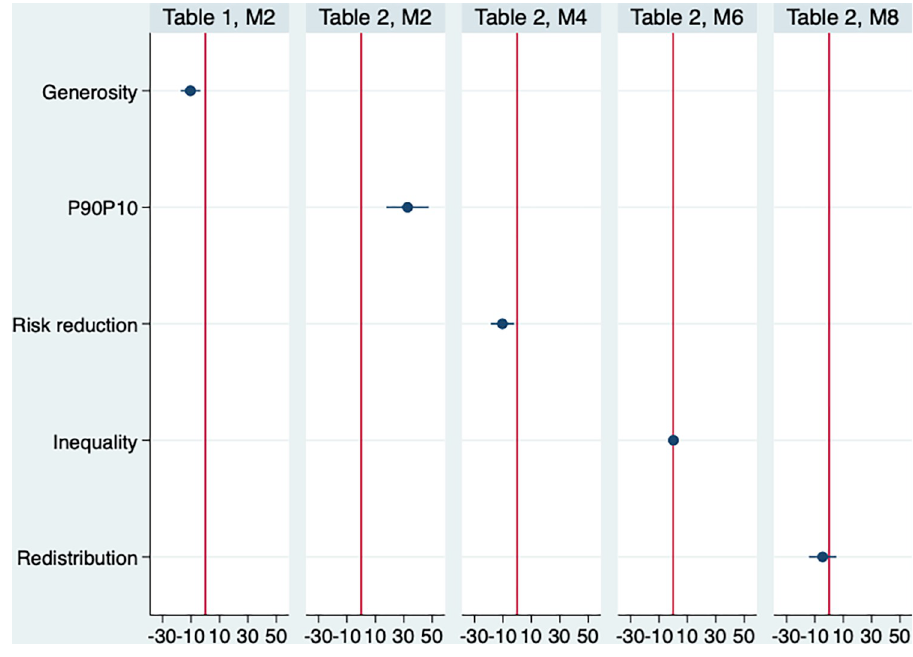
Fig 2. Standardized coefficients of the main variables on men’s death rates, based on models from Tables 1 and 2.